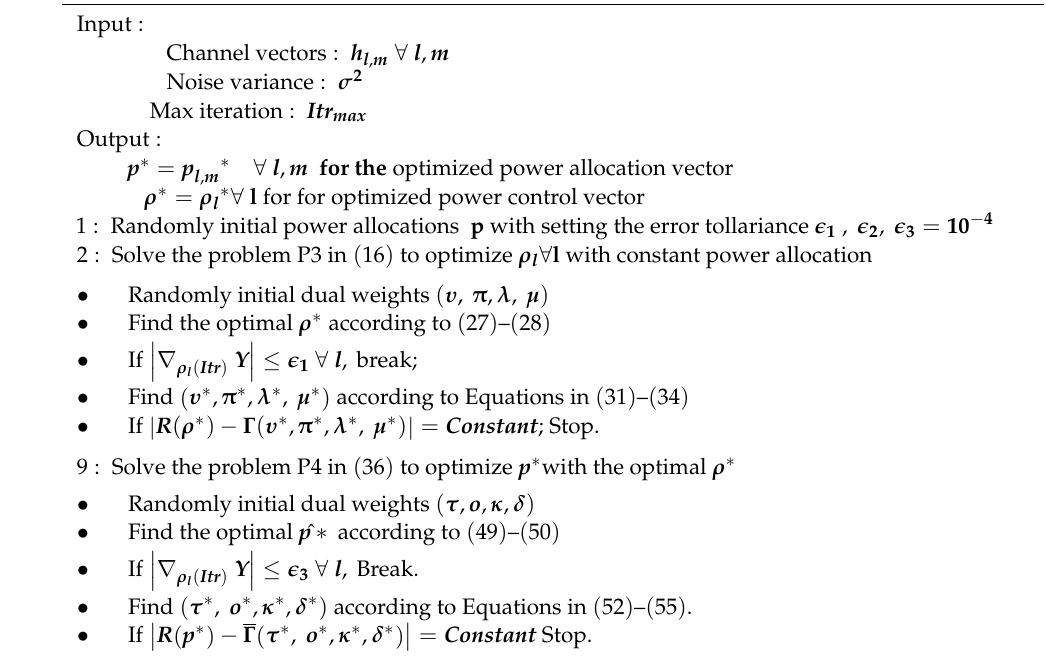
Algorithm 1 The presented method for joint optimization problem of resource allocation algorithm and power splitting